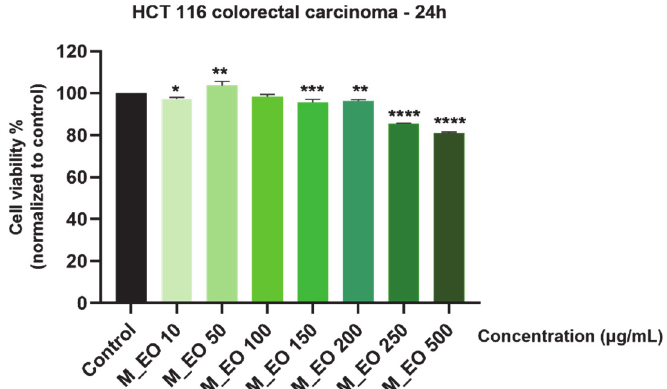
Figure 1. Viability assessment of Mentha piperita L. essential oil—M_EO (10, 50, 100, 150, 200, 250 and 500 µ g/mL) in HCT 116 cells at 24 h post-stimulation by MTT assay. The results are presented as cell viability percentage (%) normalized to control (non-stimulated) cells. These data represent the mean values ± SD of three independent experiments performed in triplicate. One-way ANOVA test was performed to determine the statistical differences in rapport with control group followed by Dunnett’s multiple comparisons post-test (* p < 0.05, ** p < 0.01, *** p < 0.001 and **** p < 0.0001).